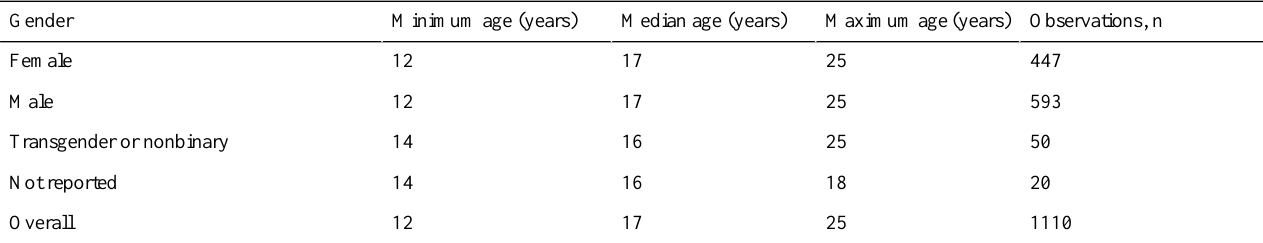
Table 1. Age and gender distribution for included